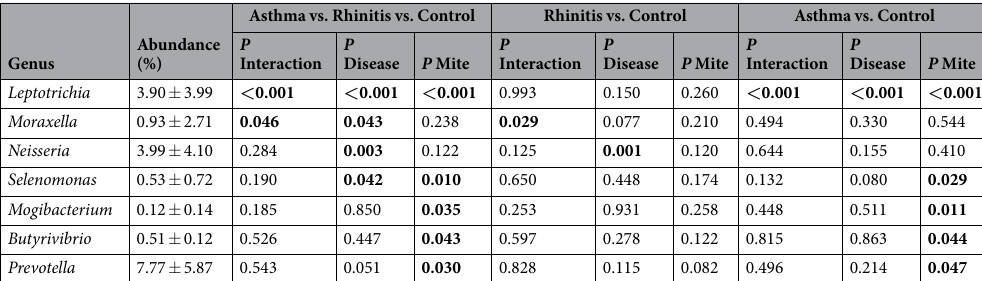
Table 3. Microbial profiles identified in the interaction of mite sensitization with rhinitis and asthma. Data shown are mean ± SD of relative abundance of bacteria. P- value was adjusted for maternal atopy, passive smoking, older siblings, household income, child’s sex and age. All P -values < 0.05, which is in bold, are